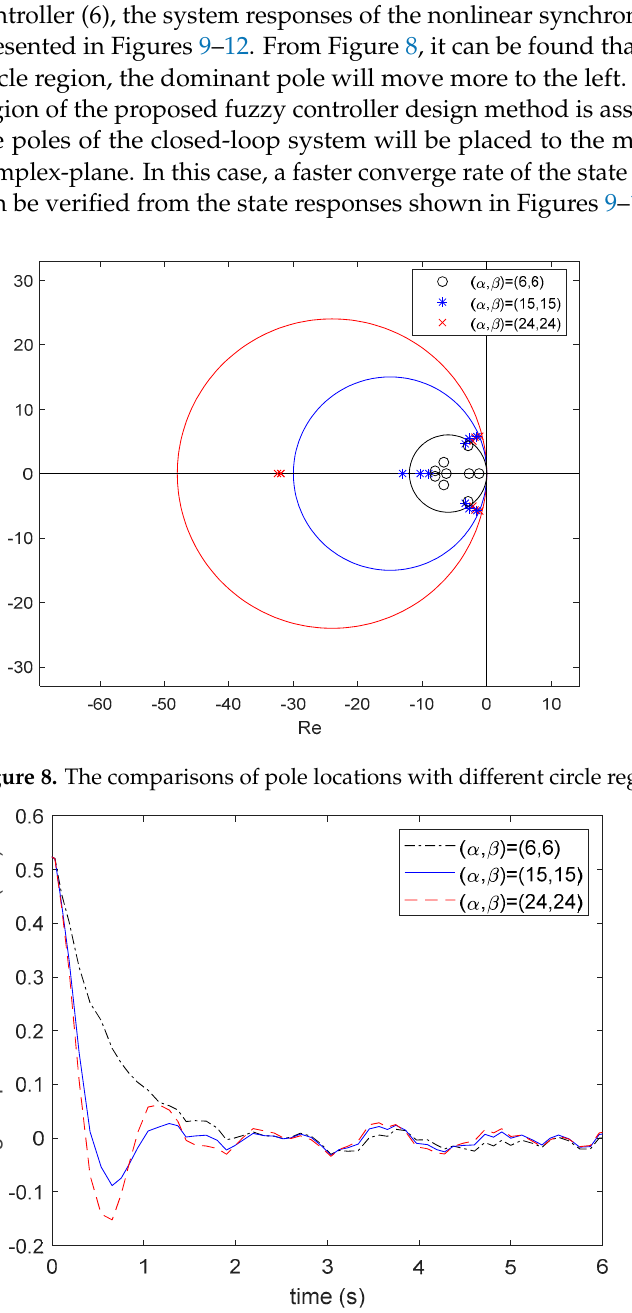
Figure 9. The comparisons of state x ( t ) responses for different circle regions.